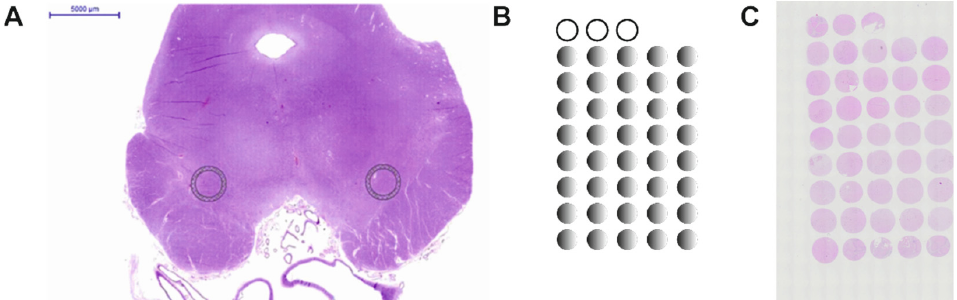
Figure 1. ( A ). Photomicrograph of a cross-section from a human mesencephalon stained with HE showing the area annotated for the punching of the SNc (circles). ( B ). Schematic drawing of a TMA with the human SNc samples (gray circles) and the non-neuronal tissue samples (open circles). ( C ). Representative photomicrograph of a TMA stained with HE.